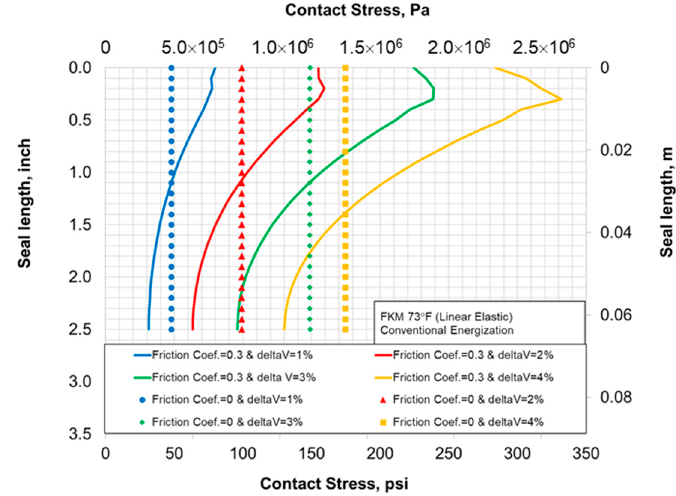
Figure 16. Effect of friction on contact stress profile in conventional seal assembly.